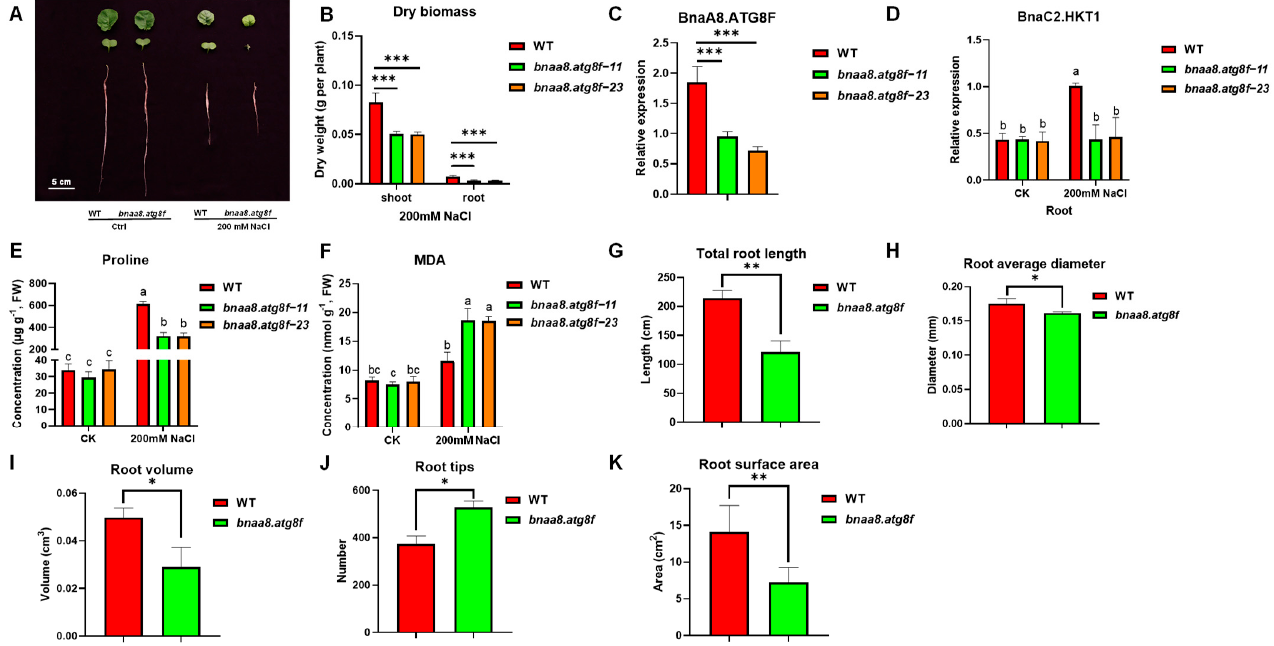
Figure 4. Downregulation of BnaA8.ATG8F reduced tolerance to salt stress. ( A ) Representative images of leaves and roots of the WT and bnaa8.atg8f after 5 d treatment with 200 mM NaCl. Ctrl, control. ( B ) Root and shoot dry weight. ( C , D ) Relative expression of ( C ) BnaA8.ATG8F in the plants and ( D ) BnaC2.HKT1 in the roots. Expression is relative to that of BnaEF1- α and BnaTublin . ( E , F ) concentrations in younger leaves of ( E ) proline and ( F ) malondialdehyde (MDA). Data are means (±SD), n = 3. Different letters indicate significant differences as determined using a one-way ANOVA followed by Tukey’s HSD test ( p < 0.05) and ( G ) total root length, ( H ) root average diameter, ( I ) root volume, ( J ) root tips, ( K ) root surface area. Significant differences were determined using Student’s t -test: * p < 0.05; ** p < 0.01; *** p < 0.001.